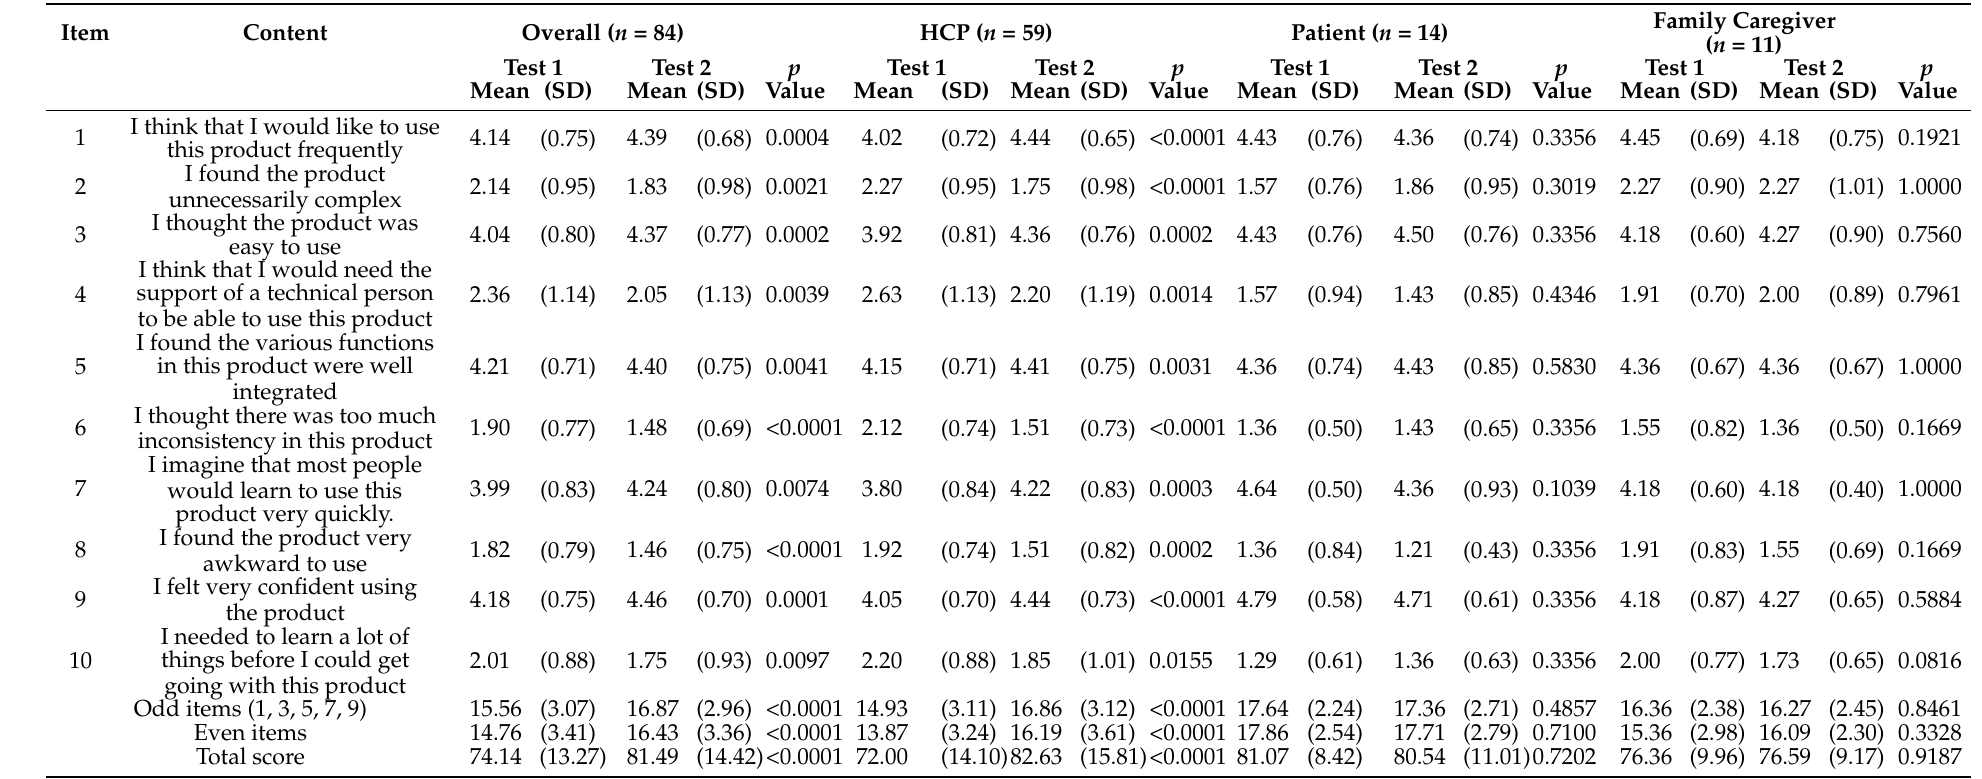
Table 2. Usability measure by